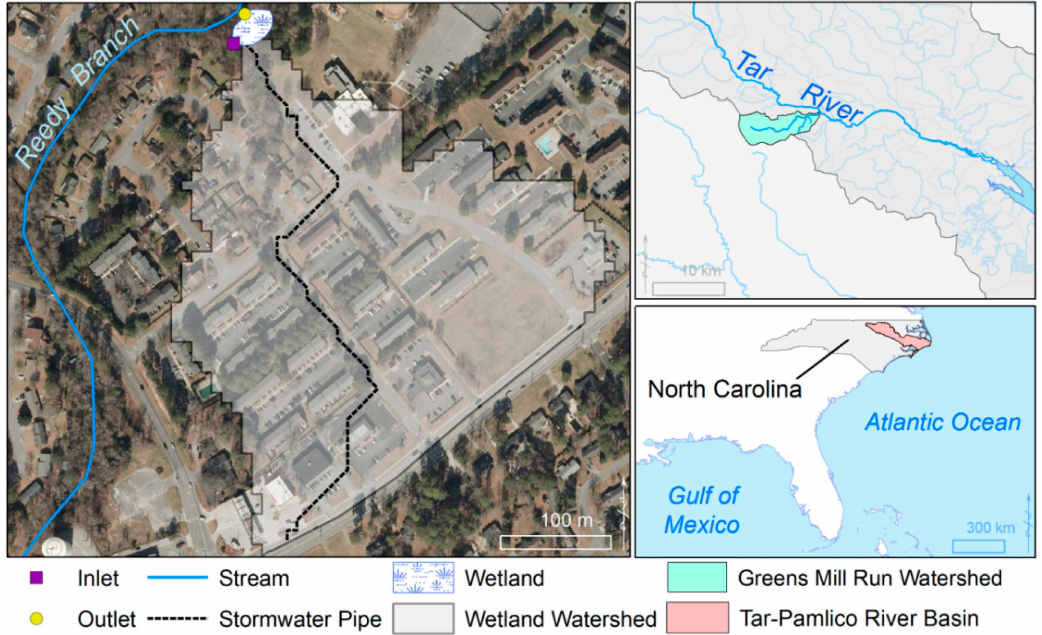
Figure 1. Watershed for a stormwater control measure (dry detention basin converted to a wetland) at Jaycee Park in the City of Greenville, NC, USA. The control measure discharges e ffl uent to Reedy Branch, a Tributary of Greens Mill Run and the Tar River.